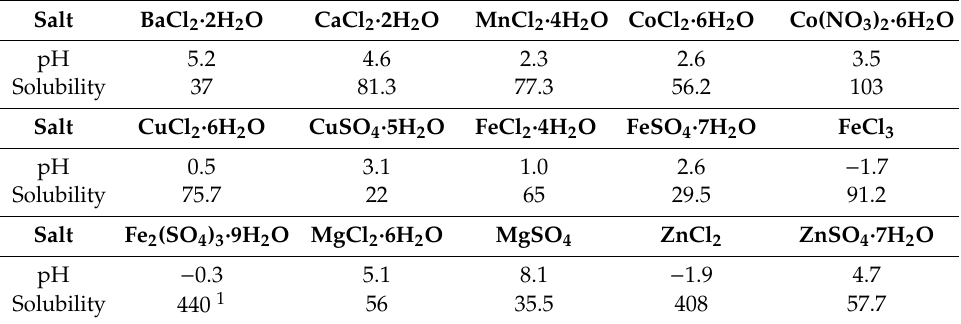
solubility in g / 100g of water at 25 ◦ C [26]. Accuracy of pH measurements: ± 0.1.